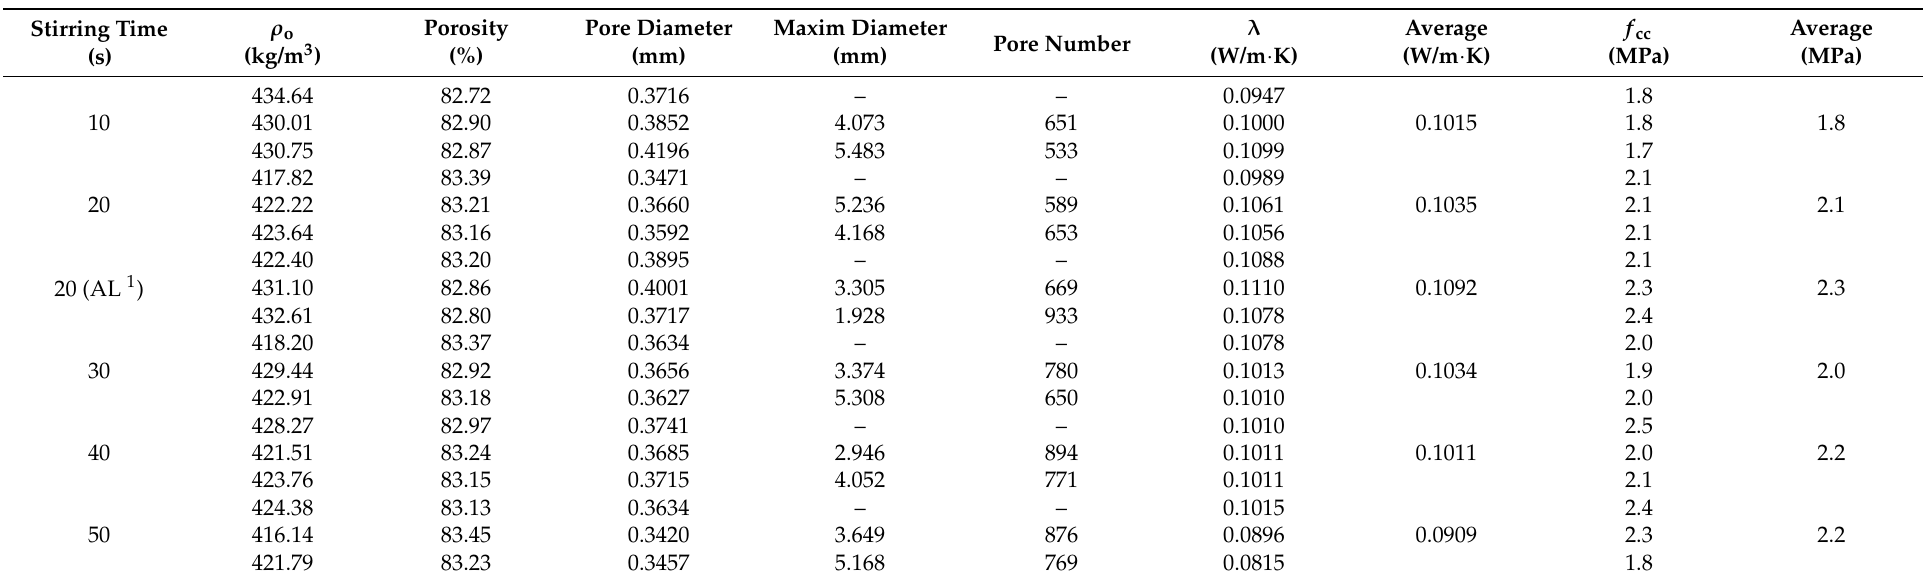
Table 5. Relationship between pore size, thermal conductivity, and compressive strength affected by stirring